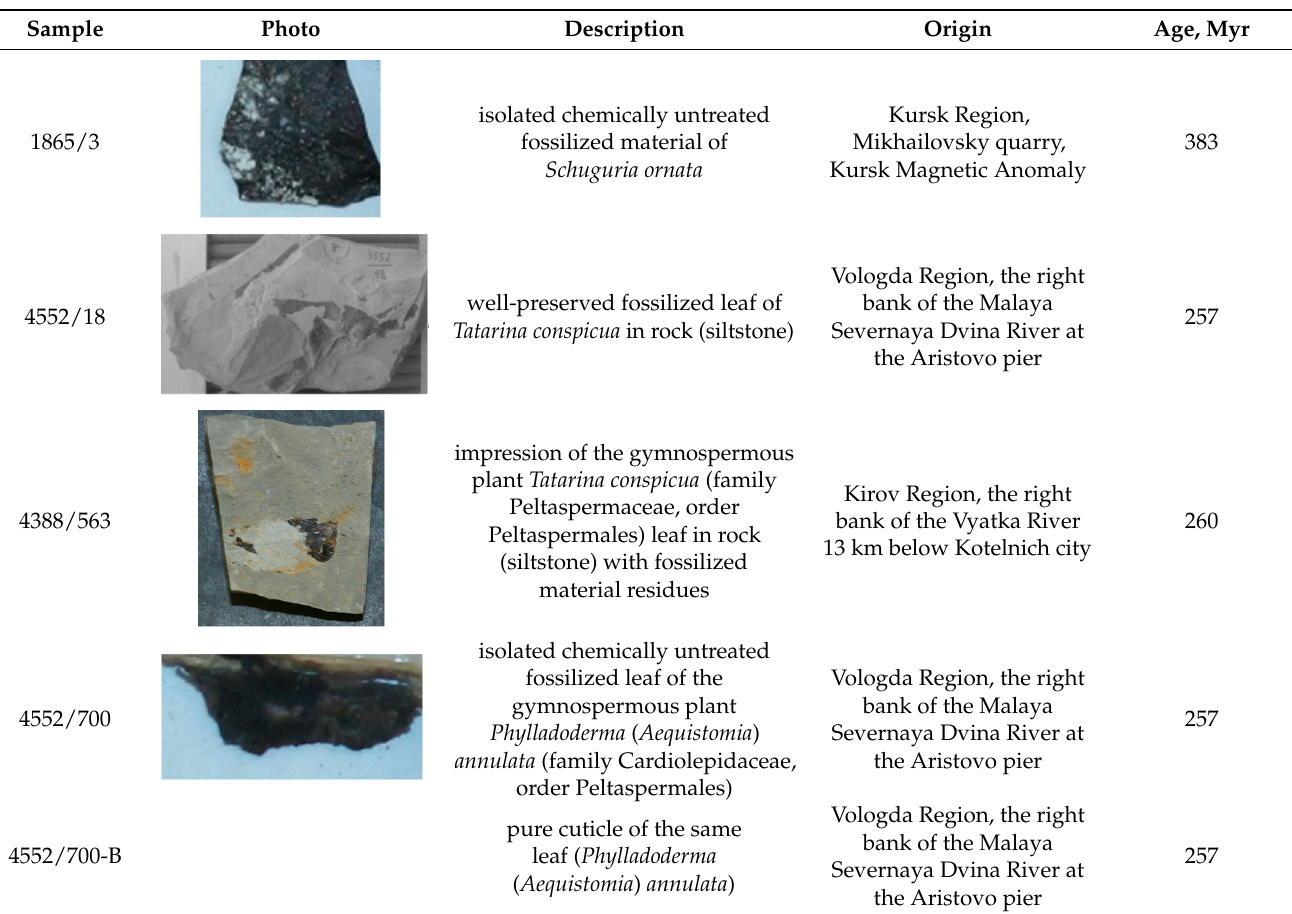
Table 1. Fossil plant (compressions) samples.